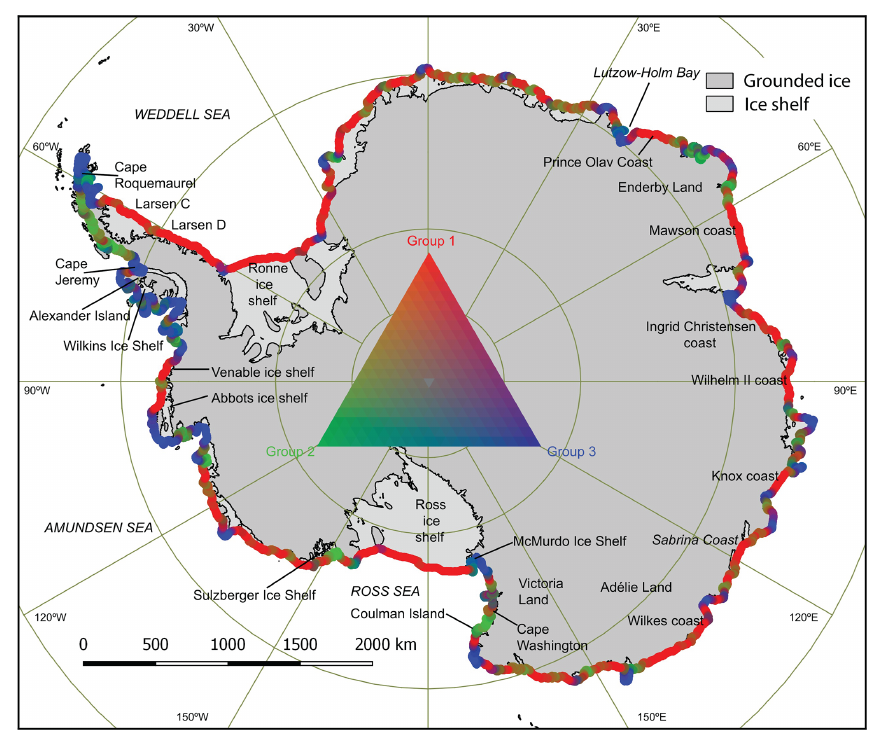
Figure 9. Spatial plot of three-group structure determined by PAM clustering at ≥ 8km length scales.